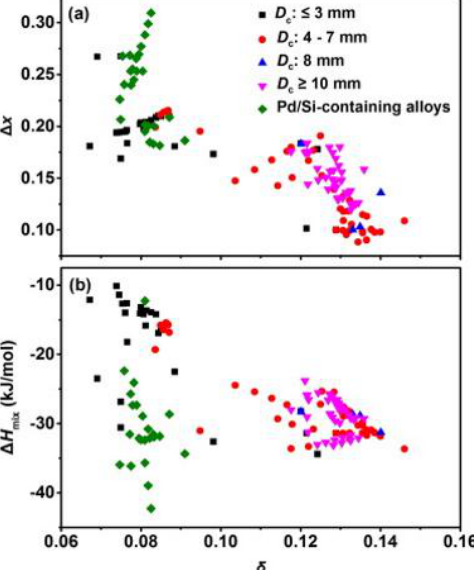
Figure 8. The distribution of ∆ x and ∆ H mix values of all the developed Ti-based BMGs with their atomic size difference δvalues. Reproduced with permission from [93]. Copyright 2015, Elsevier.